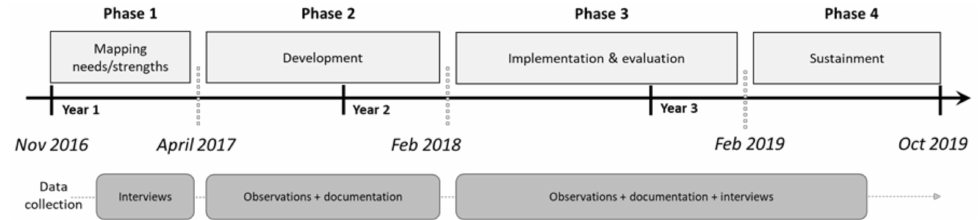
Figure 2. Schematic overview of the timeline, phases, and data collection in the case